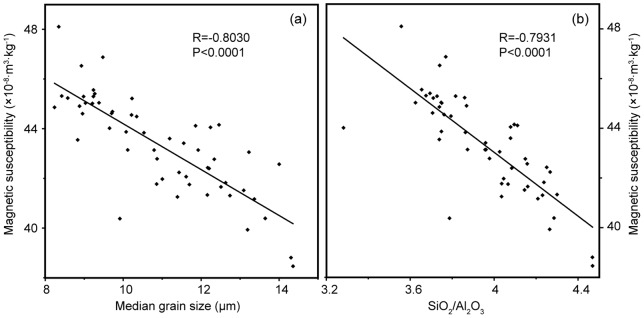
Correlations between MS and the median grain size and the SiO2/Al2O3 ratio of sediment core M38002.